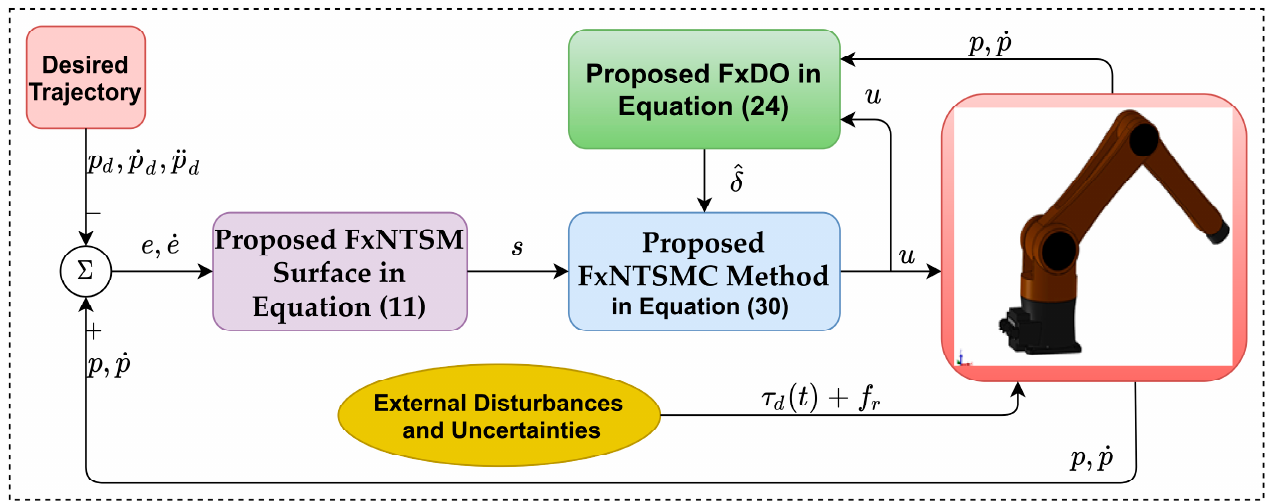
Figure 1. Block diagram of the proposed control system.